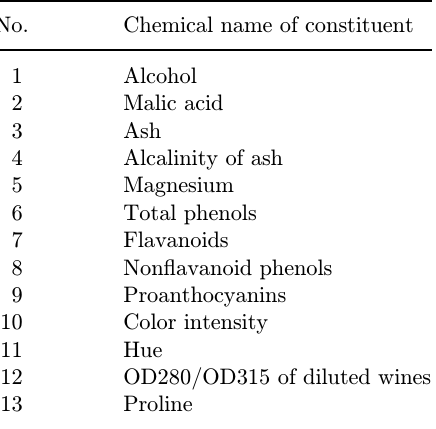
Table 4. The constituents of Wine